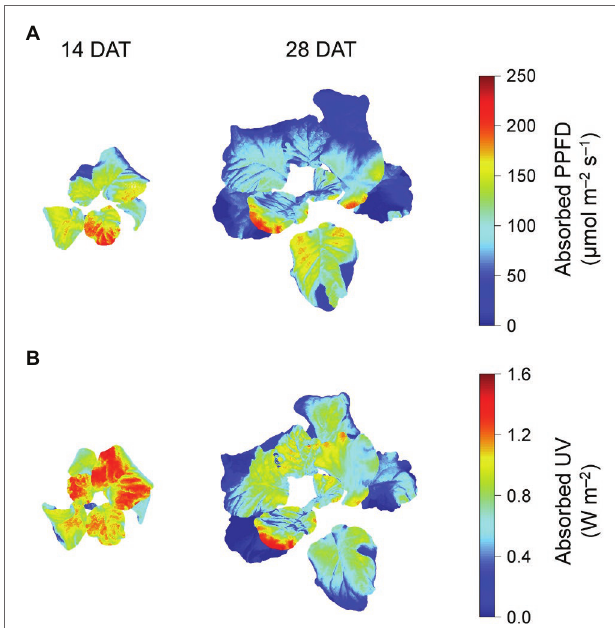
FIGURE 3 | Representative light interception distributions on 3D-scanned kale models at 14 and 28 days after transplanting (DATs). Each light interception represents the photosynthetic photon flux density (PPFD) absorbed at at 400–700 nm (A) and UV absorbed at 250–400 nm (B)